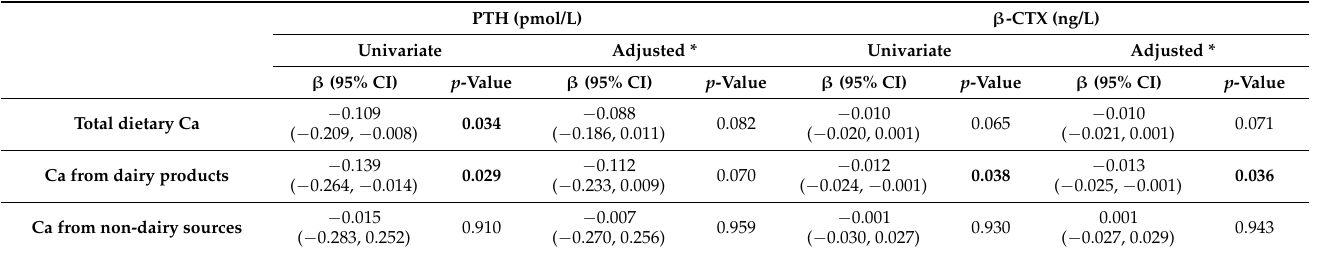
Table 3. Associations (linear regressions) between PTH and β -CTX (dependent variables) and calcium intakes (continuous independent variable, per 300 mg increase) at the baseline visit of the cohort in the total study population ( n =